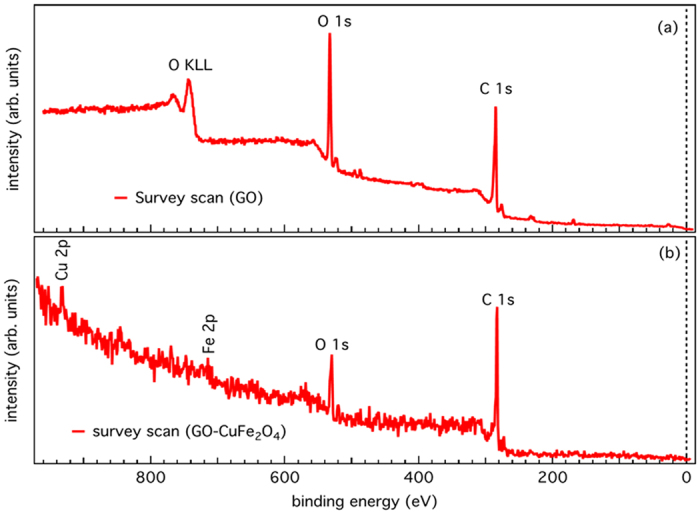
XPS survey scan of (a) GO and (b) GO-CuFe2O4 nanocomposite samples.